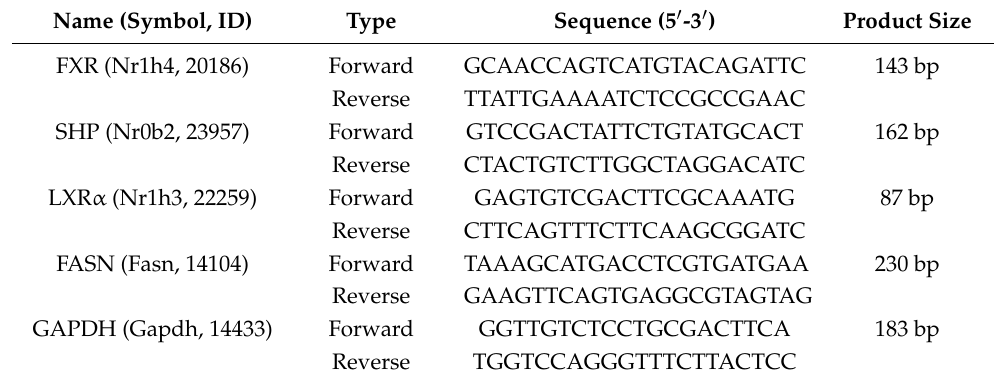
Table 1. Specific primers for